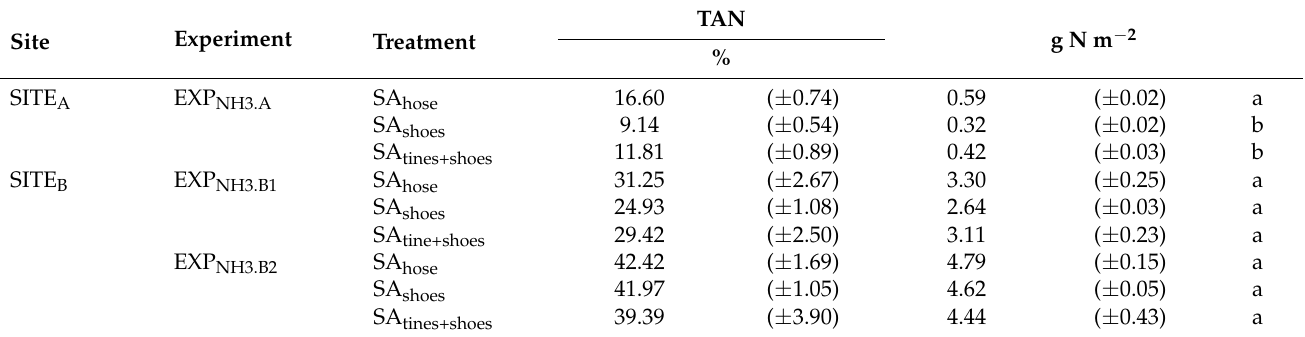
Table 7. Cumulative NH 3 emission as a percentage of applied total ammoniacal N (TAN) and g N